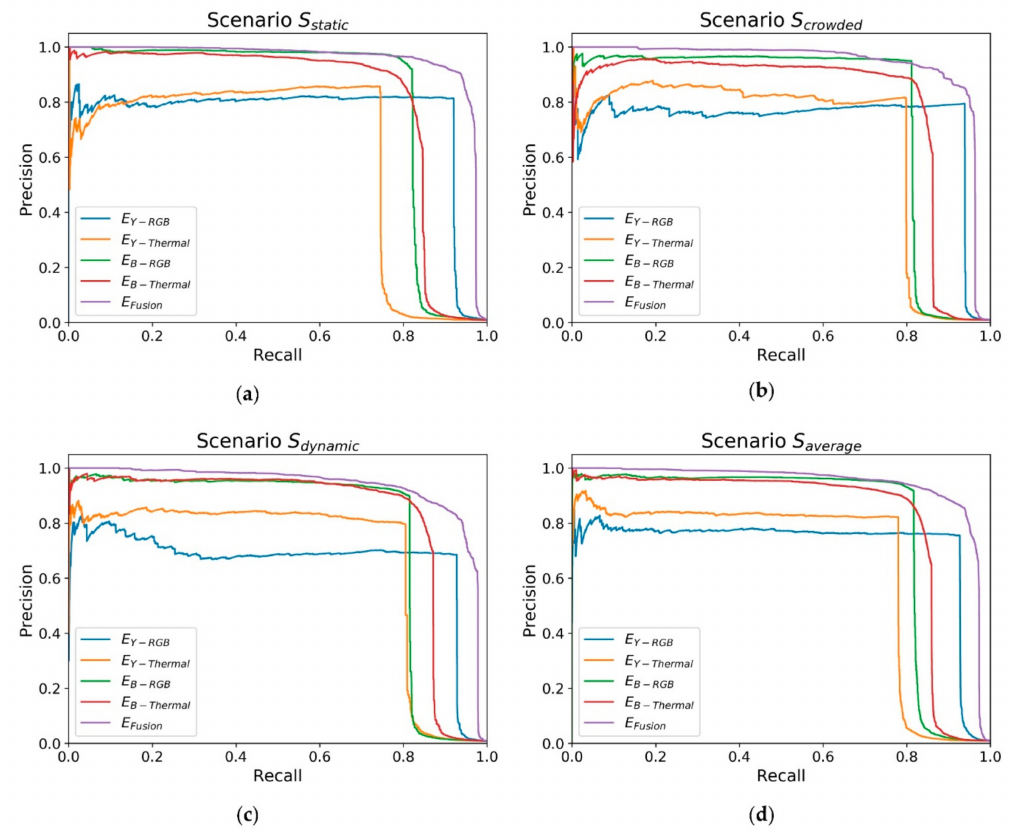
Figure 21. Evaluation of the expert performances in di ff erent scenarios. ( a ) S static ; ( b ) S crowded ; ( c ) S dynamic ; ( d ) all scenarios ( S average